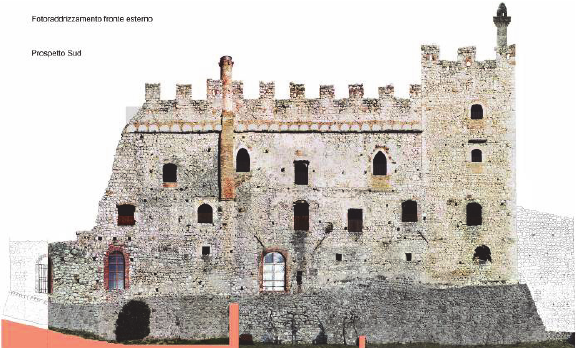
Figure 5: Castello di Avio 2002 (Tn). Rectified Image (1:50) of the inside fronts of the baronial building of the castle of Avio, (Studio Campanella Tessoni).